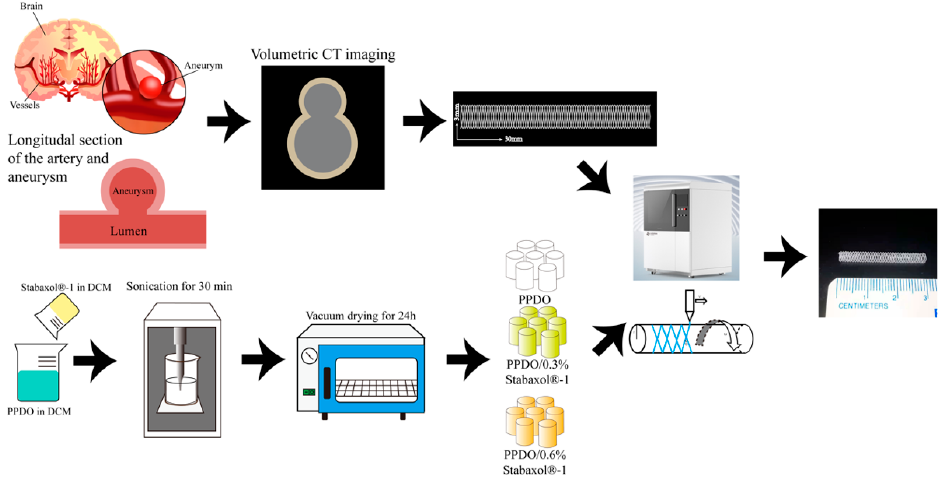
Figure 1. Detailed illustration of preparation process of PPDO stents. The length and diameter of the target vessel were measured by CT imaging and the obtained parameters were imported into the 3D printer. Using PPDO/stabaxol ® -1 composite with different proportions of stabaxol ® -1 as ink, the corresponding BRSs were individually